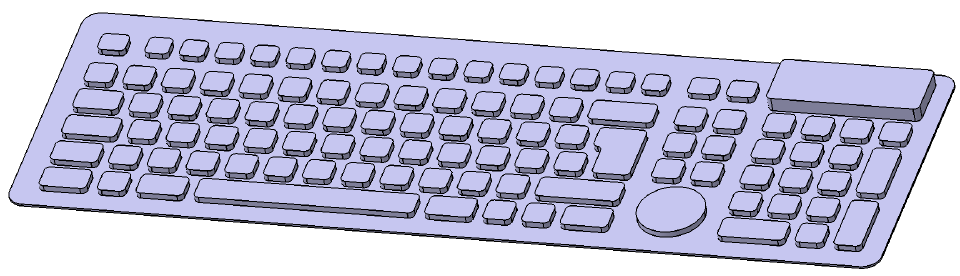
Figure 7. CAD image of keyboard design generated for additive manufacturing with TPU material.